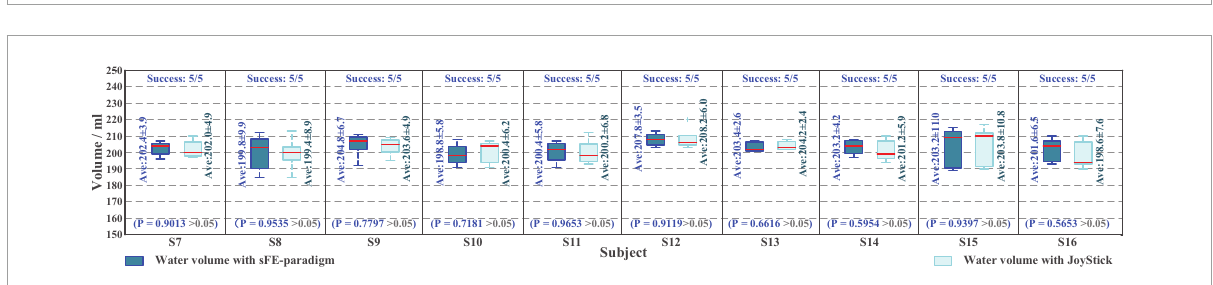
FIGURE23 The boxplot of water volume in online experiment Task two with slight-facial expression (sFE)-paradigm and JoyStick, where the short red line indicates the median, and the number indicates the mean.